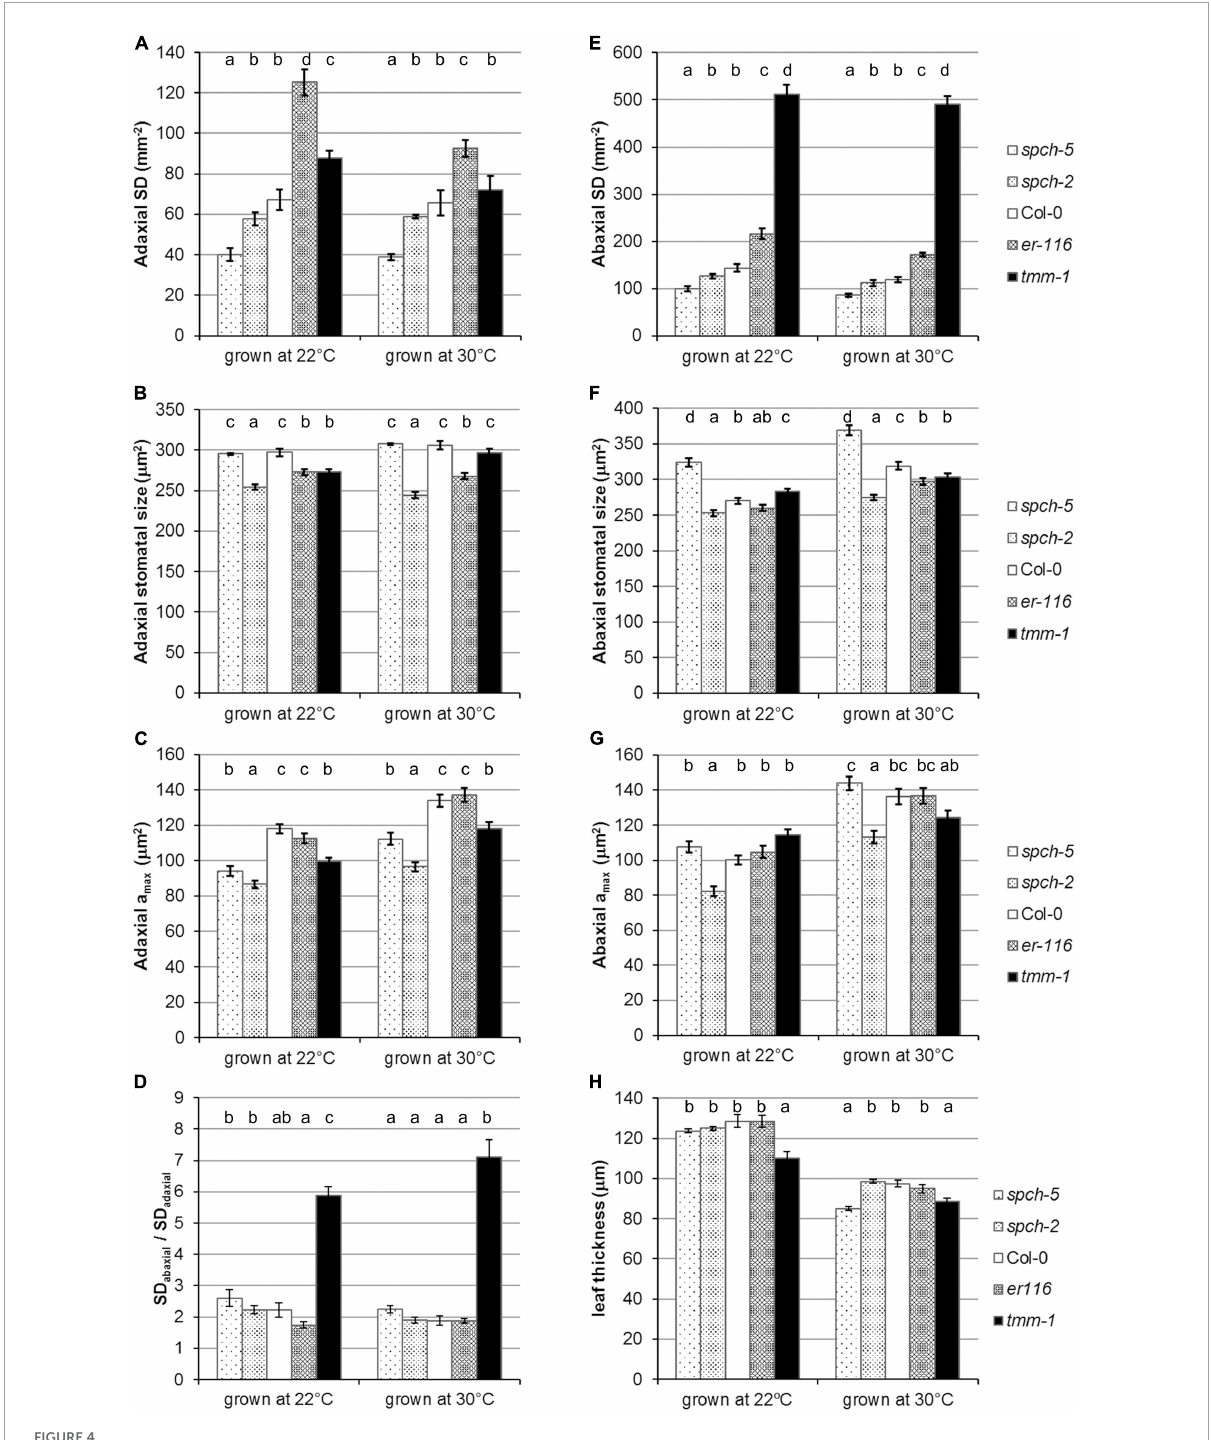
FIGURE4 Stomatal phenotypes under optimal and supra-optimal growth temperature. Stomatal density (A,E) and stomatal size (B,F) for adaxial and abaxial side, respectively, of fully expanded leaves. (C,G) Maximum stomatal pore size ( a max ) on the adaxial and abaxial sides of the leaf, respectively, at 23 dag for 22 ◦ C and 17 dag for 30 ◦ C. (D) Stomatal density ratio SD abaxial /SD adaxial . (H) Thickness of mature leaves from plants grown under 22 and 30 ◦ C. Values are means ± SE, calculated from n = 7 (A–G) and n = 6–18 (H) . Different letters above the bars indicate statistically significant differences between genotypes at the same growth temperature ( p ≤ 0.05) according to one-way ANOVA followed by the Dunnet’s T3 test (30 ◦ C data in panel A ) or the Kruskal–Wallis test followed by the Dunn’s test (the rest of